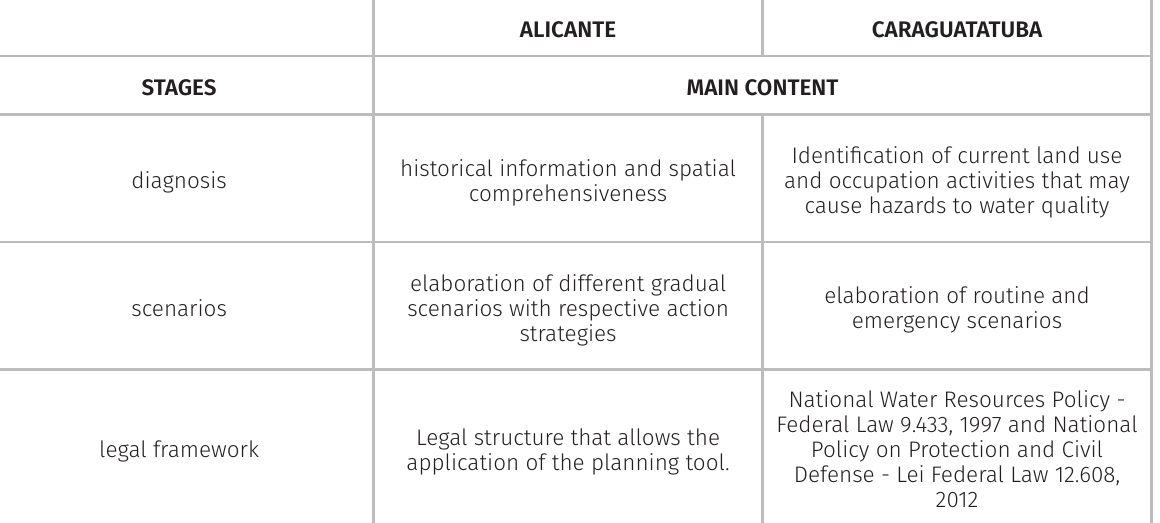
Table V. Comparison between the procedures for the elaboration of stages of the water conflicts management system with the land use and occupation adopted in Alicante with the Caraguatatuba Water Safety Plan (source: elaborated by the